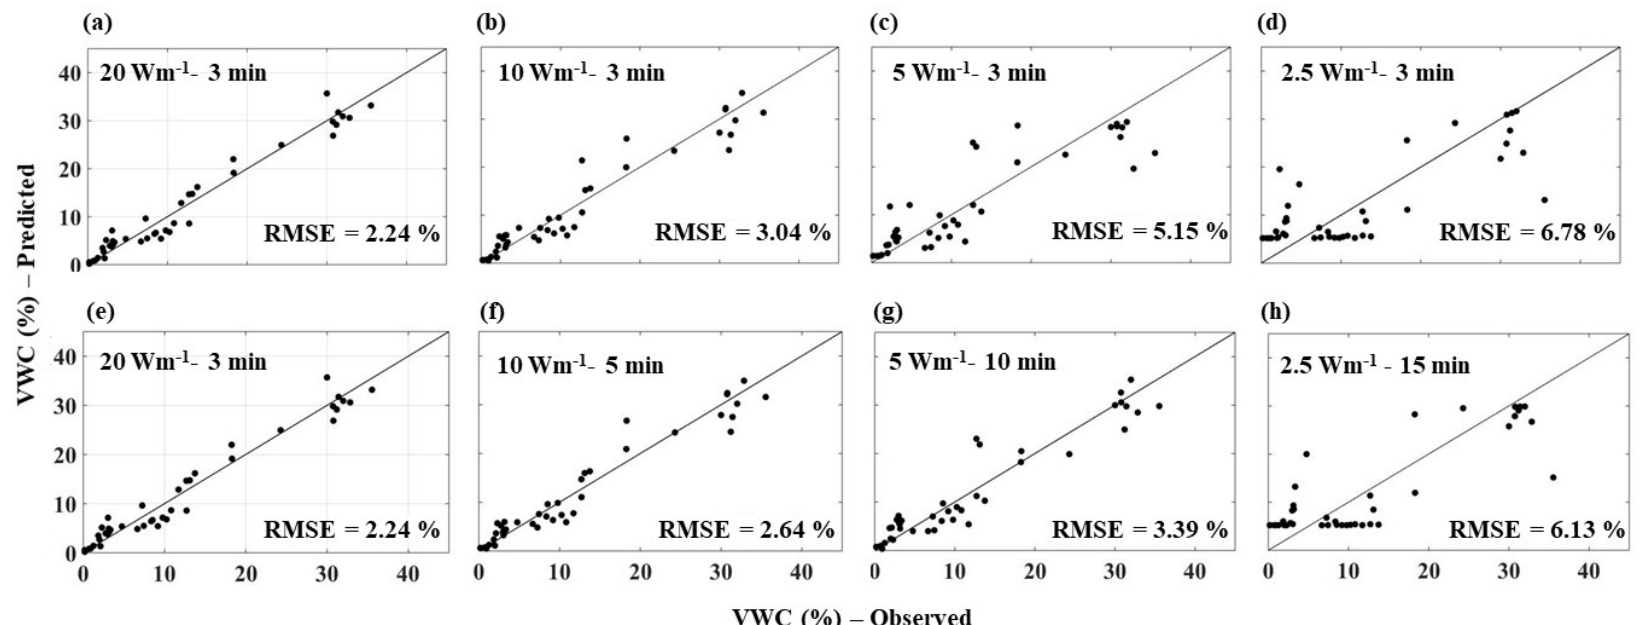
Figure 8. Comparison between AHFO predicted and observed (gravimetric method) soil water content of sandy soil for all the heating strategies. Note: ( a , e ) are similar (20 Wm − 1 –3 min) and are used to compare with the short pulses (along row 1) and with the long pulses (along row 2).